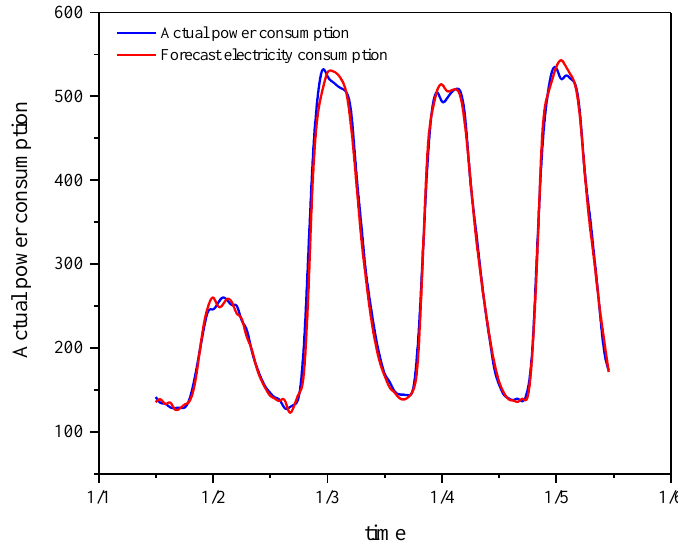
Figure 14. Forecast of air-conditioning energy consumption in a week.